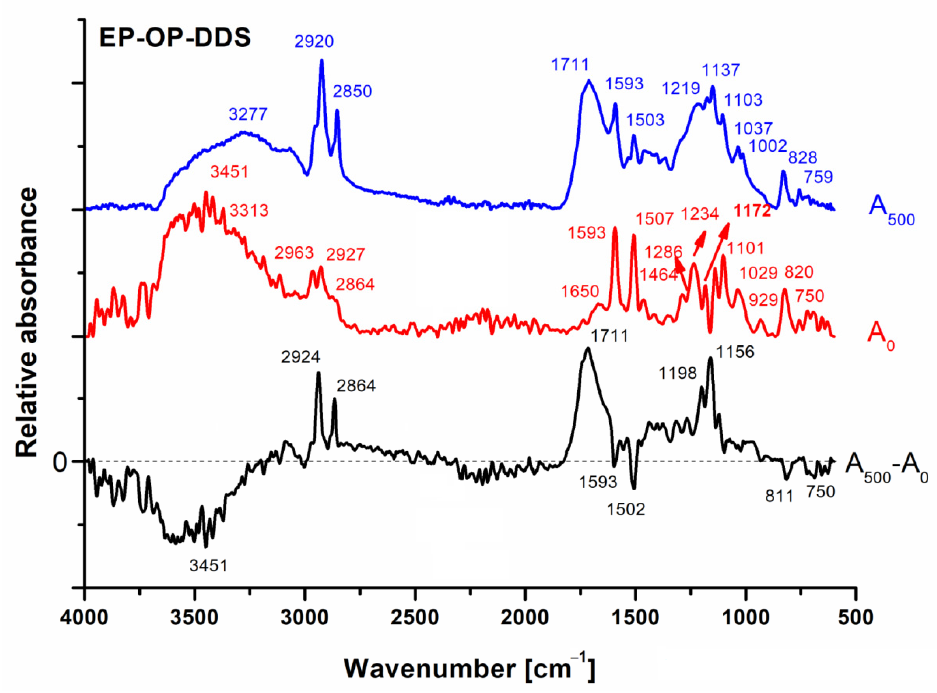
Figure 6. FT-IR spectra of the S–IPN EP–OP–DDS recorded before (A 0 ) and after 500 h exposure (A 500 ) and the difference spectrum (A 500 –A 0 ).